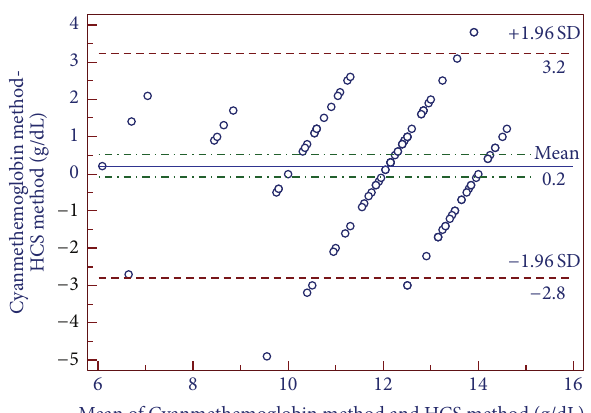
Figure 1: Bland-Altman plot for the haemoglobin colour scale com- pared with the reference method (cyanmethemoglobin